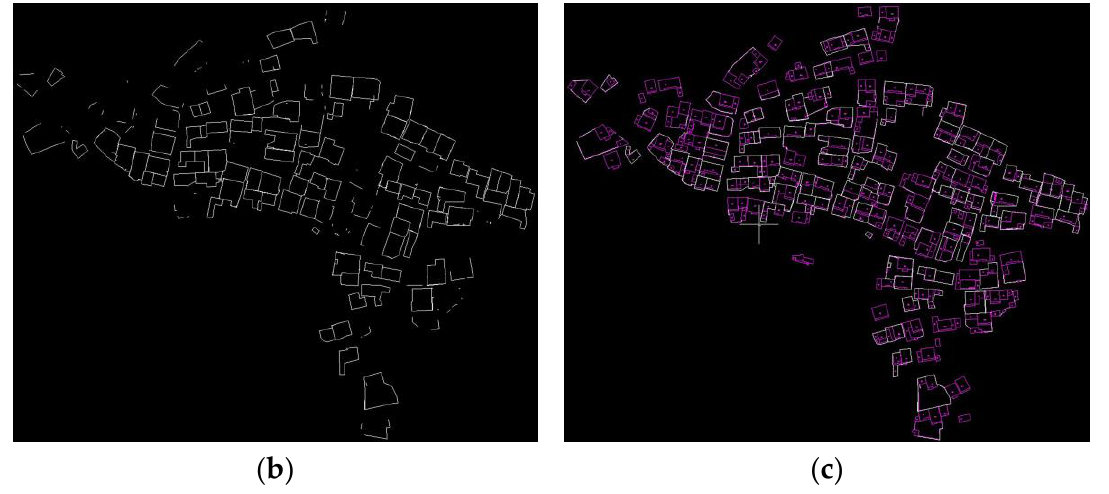
Figure 7. A comparative result of: ( a ) the fused data with the building vector map (purple); ( b ) the extracted building contours (white); and ( c ) overlapping the extracted building contours and building vector map.